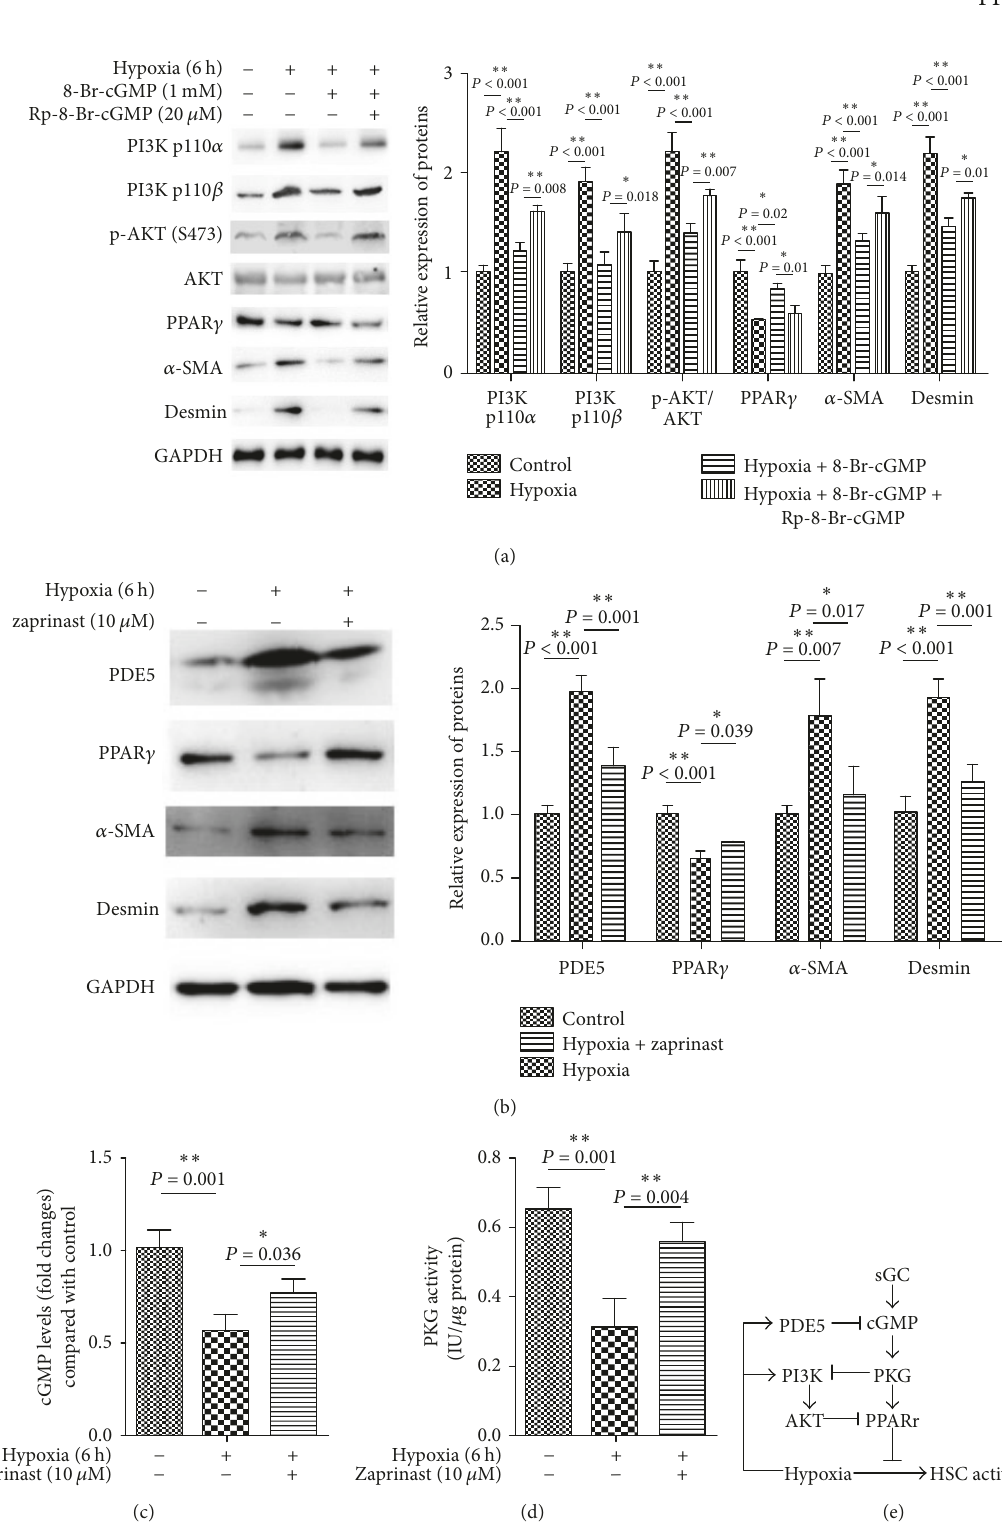
Figure 4: sGC/cGMP/PKG and PI3K/AKT signals synergistically act on PPAR 𝛾 to inhibit hypoxia-induced HSC activation. (a) HSCs were exposed to hypoxia in the presence of cGMP analog, 8-Br-cGMP (1mM), or agonist, Rp-8-Br-cGMPs (20 𝜇 M). PI3K p100 𝛼 , p100 𝛽 , phosphorylated AKT, total AKT, PPAR 𝛾 , 𝛼 -SMA, and desmin expression of HSCs in experimental groups were detected by western blotting. HSCs were exposed to hypoxia in the presence of PDE5 agonist, zaprinast (10 𝜇 M). (b) PDE5, PPAR 𝛾 , 𝛼 -SMA, and desmin expression of HSCs in experimental groups were measured by western blotting. (c)-(d) cGMP and PKG activity were tested, respectively. (e) Possible signal pathway involved in this study. Hypoxia induces HSCs activation. However, PPAR 𝛾 inhibits this effect, which is triggered by sGC/cGMP/PKG signaling. Hypoxia promotes PI3K/AKT signaling and PDE5, which inhibit cGMP and PPAR 𝛾 , respectively. Finally, sGC/cGMP/PKG and PI3K/AKT signals synergistically act on PPAR 𝛾 to inhibit hypoxia-induced HSC activation. For each assay, 𝑛 = 3 . ∗ 𝑃 < 0.05 , ∗∗ 𝑃 < 0.01